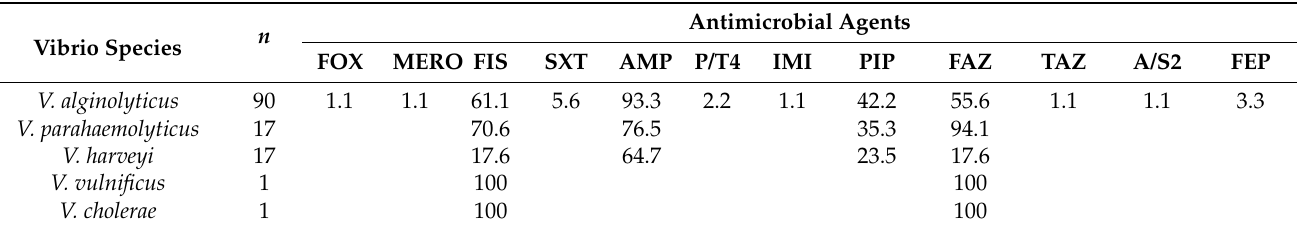
Table 4. Resistance percentages to single antimicrobial agents. The antimicrobial agents for which no resistance was found are not